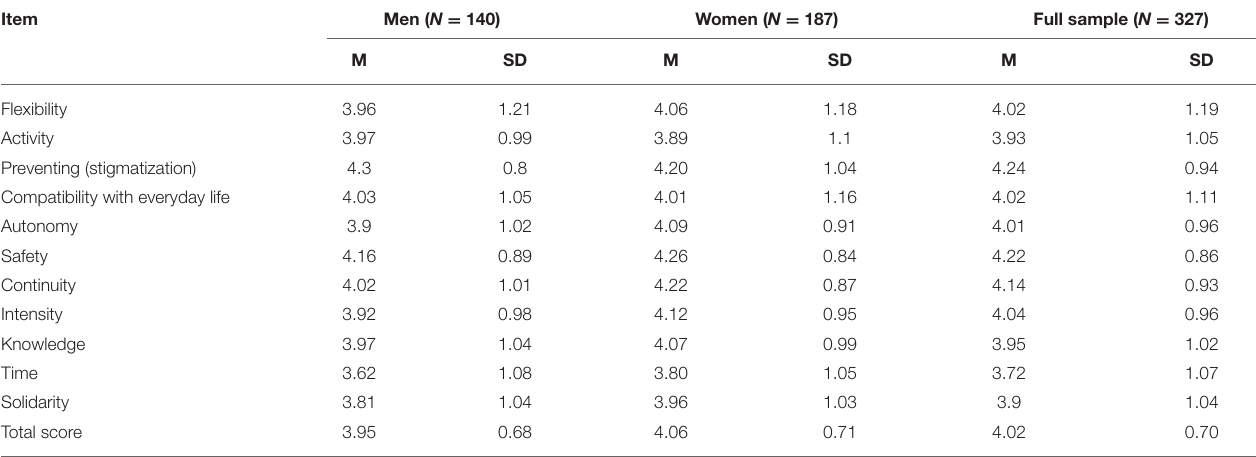
TABLE 2 | Correlations on NEPT items and Cronbach’s alpha ( α